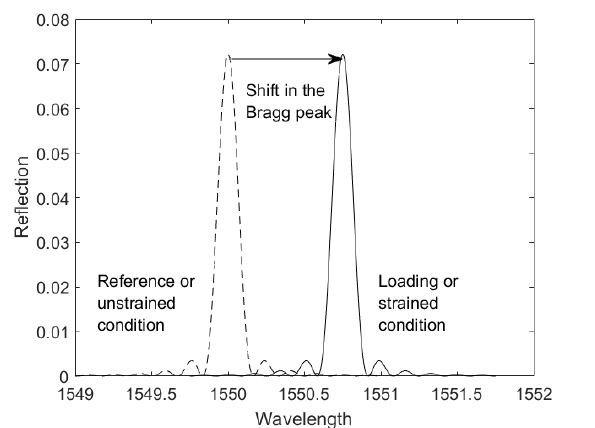
Figure 1. Shift in the Bragg peak ( ∆ λ B ) due to an applied strain.